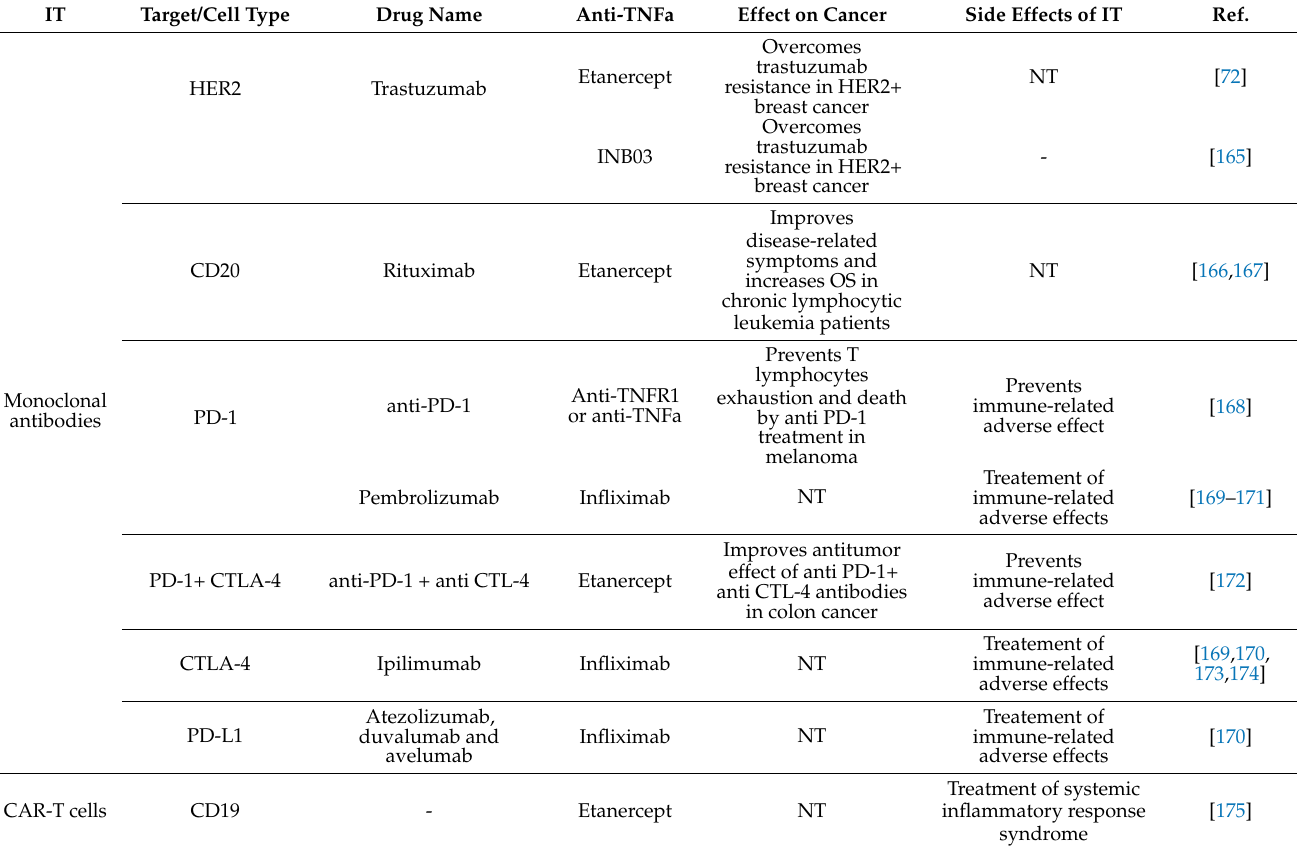
Table 2. Impact of anti-TNF α drugs in cancer